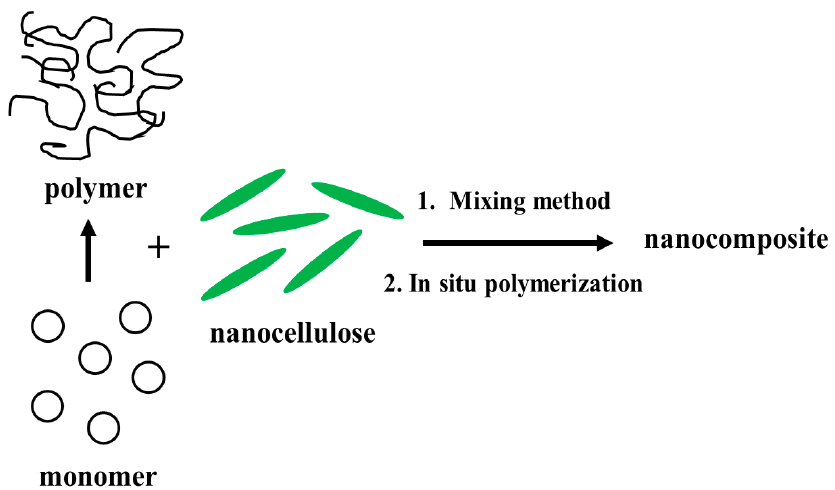
Figure 5. Producing TPU composites containing